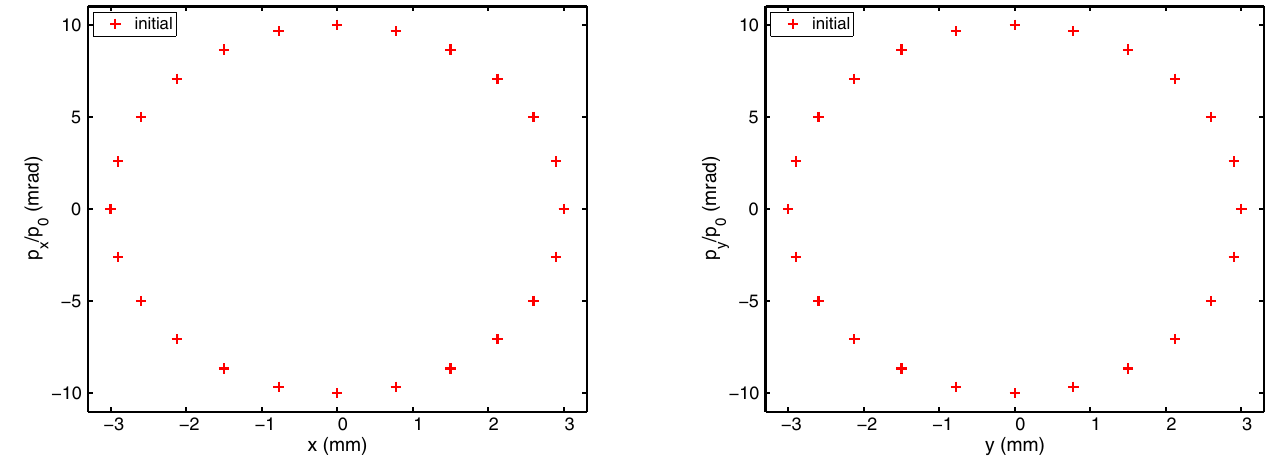
FIG. 13. Initial in-plane (left) and out-of-plane (right) phase space at the collimator. 30 π mm-mrad.